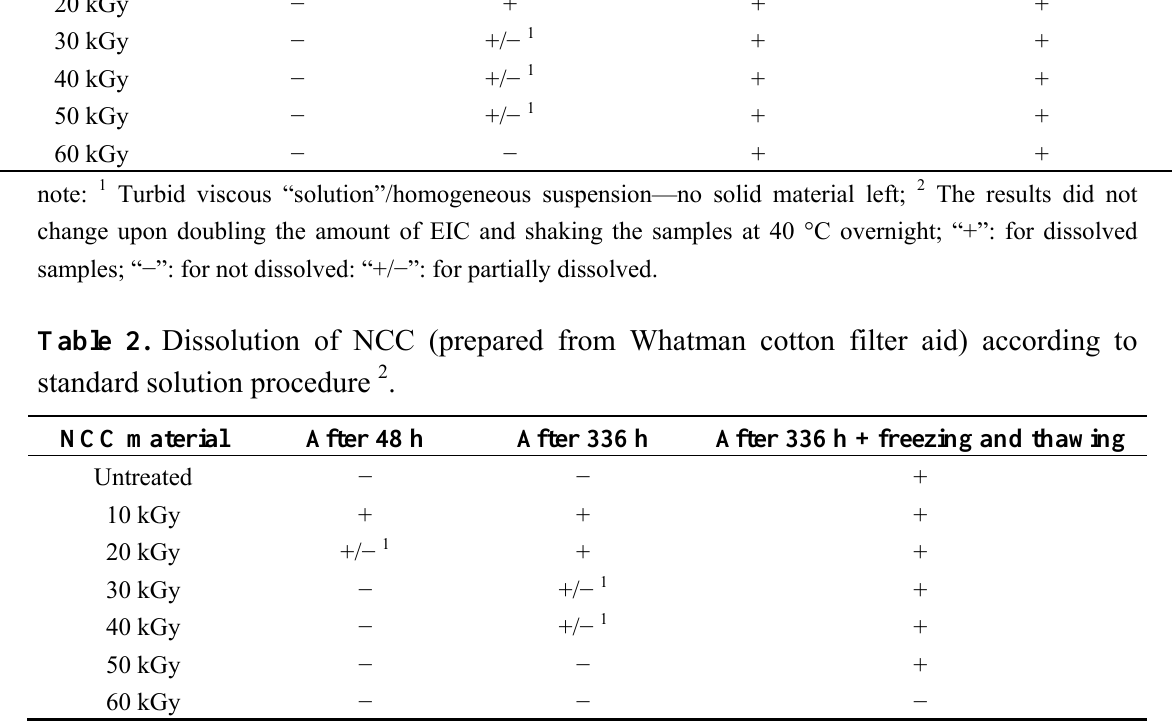
Table 1. Impact of irradiation on the solubility of MFC produced by mechanical fibrillation of northern bleached softwood kraft (NBSK) pulp (according to standard dissolution procedures as described in Section 3.4 and ethyl isocyanate (EIC) supported dissolution). EIC-supported After 24 h in After 72 h in EIC-supported MFC-material dissolution after 672 h 9% DMAc/LiCl 9% DMAc/LiCl dissolution 2 after 48 h untreated − + − − 10 kGy − + − − 20 kGy − + + + 30 kGy − +/ − 1 + + 40 kGy − +/ − 1 + + 50 kGy − +/ − 1 + + 60 kGy − − + + note: 1 Turbid viscous “solution”/homogeneous suspension—no solid material left; 2 The results did not